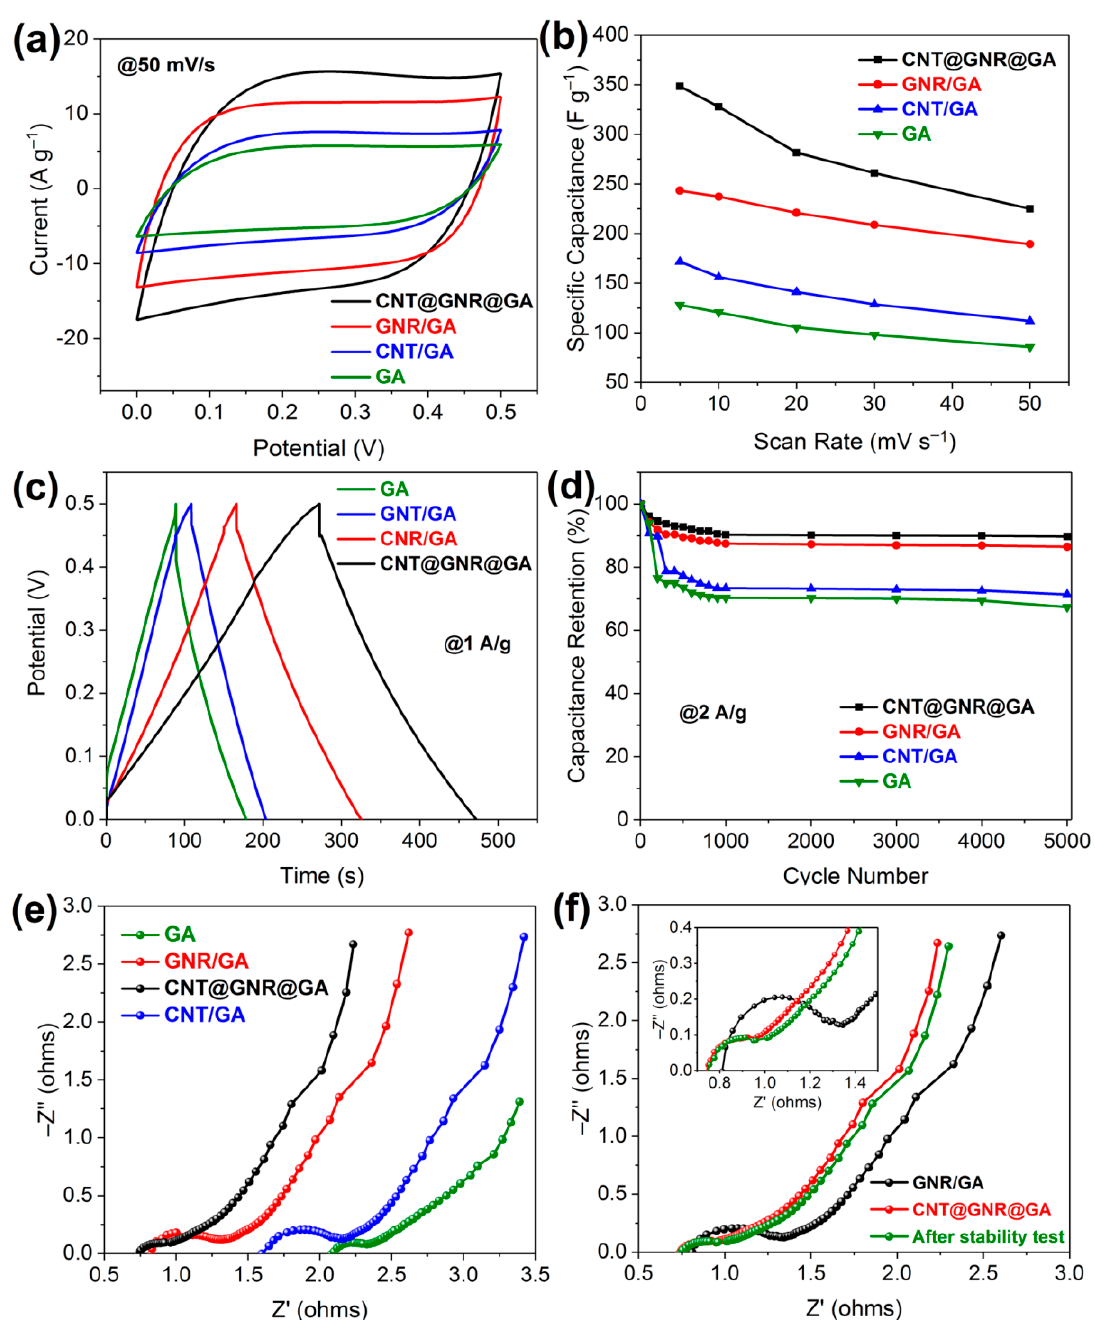
Figure 5. Electrochemical performance of aerogels in 6 M KOH: ( a ) CV curves at a scan rate of 50 mVs − 1 ; ( b ) calculated specific capacitance at various scan rates; ( c ) the GCD curves at a current density of 1 Ag − 1 ; ( d ) cyclic stability obtained from the GCD test at a current density of 2 Ag − 1 ; ( e ) Nyquist plots collected by EIS; ( f ) Nyquist plots for CNT@GNR@GA before and after cyclic stability test and GNR/GA.